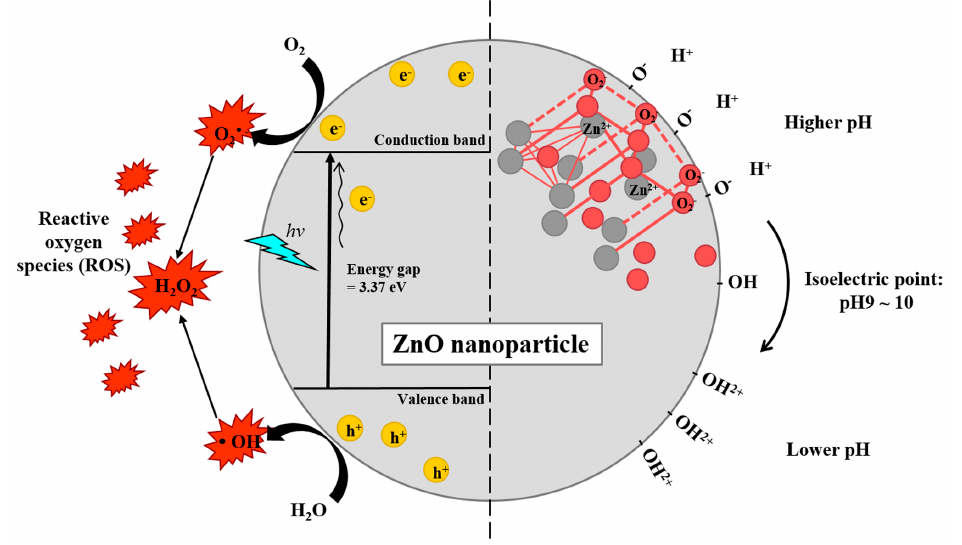
Figure 2. Schematic diagrams of potential mechanisms generating reactive oxygen species (ROS) by ZnO nanocomposite (left) and surface charge shift depending on environmental pH (right). ZnO has a large bandgap energy (3.37 eV) separated by the conduction band and valence band. When the ZnO absorbs light in UV range, electrons (e − ) get excited and promoted into the conduction band from the valence band, leaving holes (h + ). Both excited electrons and holes are strong agents in ROS generation. The crystallite structure of ZnO is usually hexagonal wurtzite structure in which each anion is surrounded by four cations at the corners of a tetrahedron, and vice versa, respectively. ZnO has an isoelectric point at pH 9–10. The neutral hydroxyl groups on their surface either gain or lose protons from and into the surrounding, depending on the surrounding pH. Therefore, ZnO nanocomposites carry positive surface charge under physiological conditions (pH < 7.4), aiding their intracellular uptake.